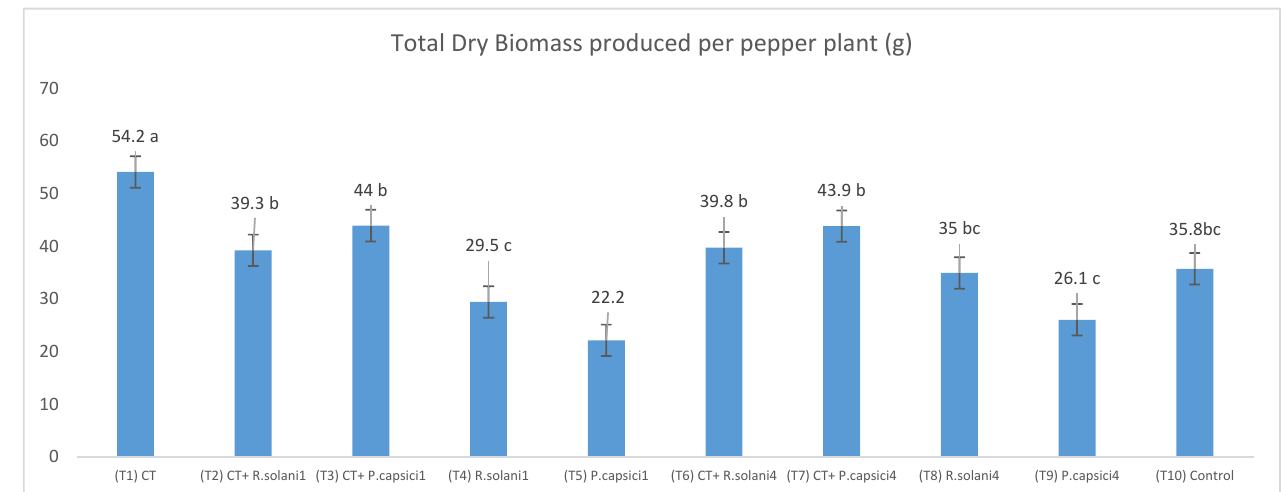
Figure 4. Total dry biomass produced per pepper plant and treatment. T1: CT (compost tea); T2 and T3: CT + pathogen inoculated one week after transplanting; T4 and T5: pathogen inoculated one week after transplanting; T6 and T7: CT + pathogen inoculated four weeks after transplanting; T8 and T9: pathogen inoculated four weeks after transplanting; T10: control. Different letters above the columns indicate significant differences (p<0.05).